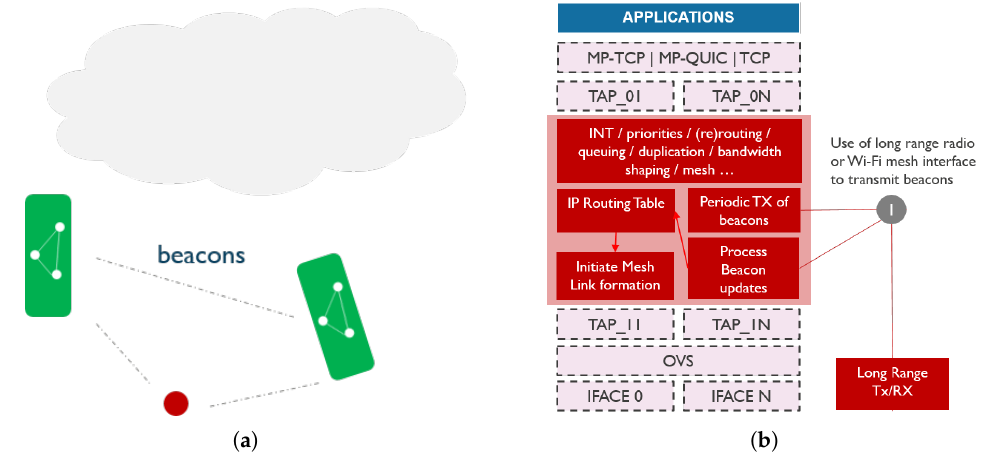
Figure 6. Decentralized discovery including ( a ) schematic representation of network topology and ( b ) communication stack